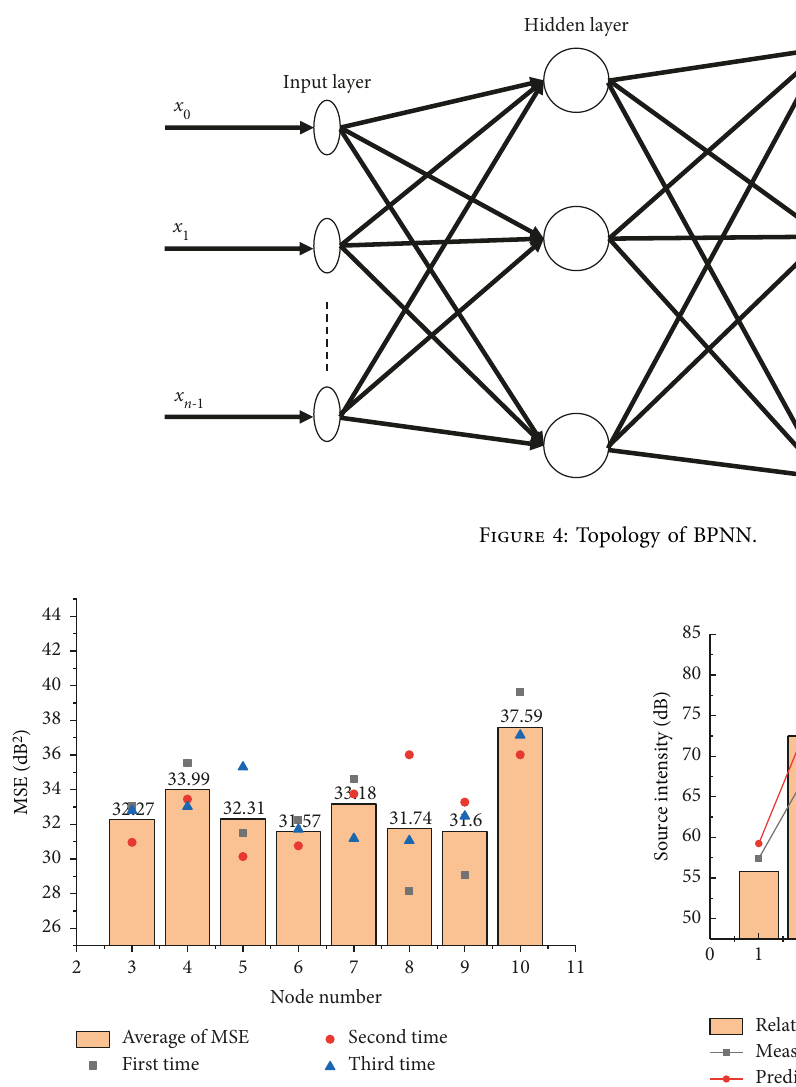
Figure 6: Predicted result of back propagation neural